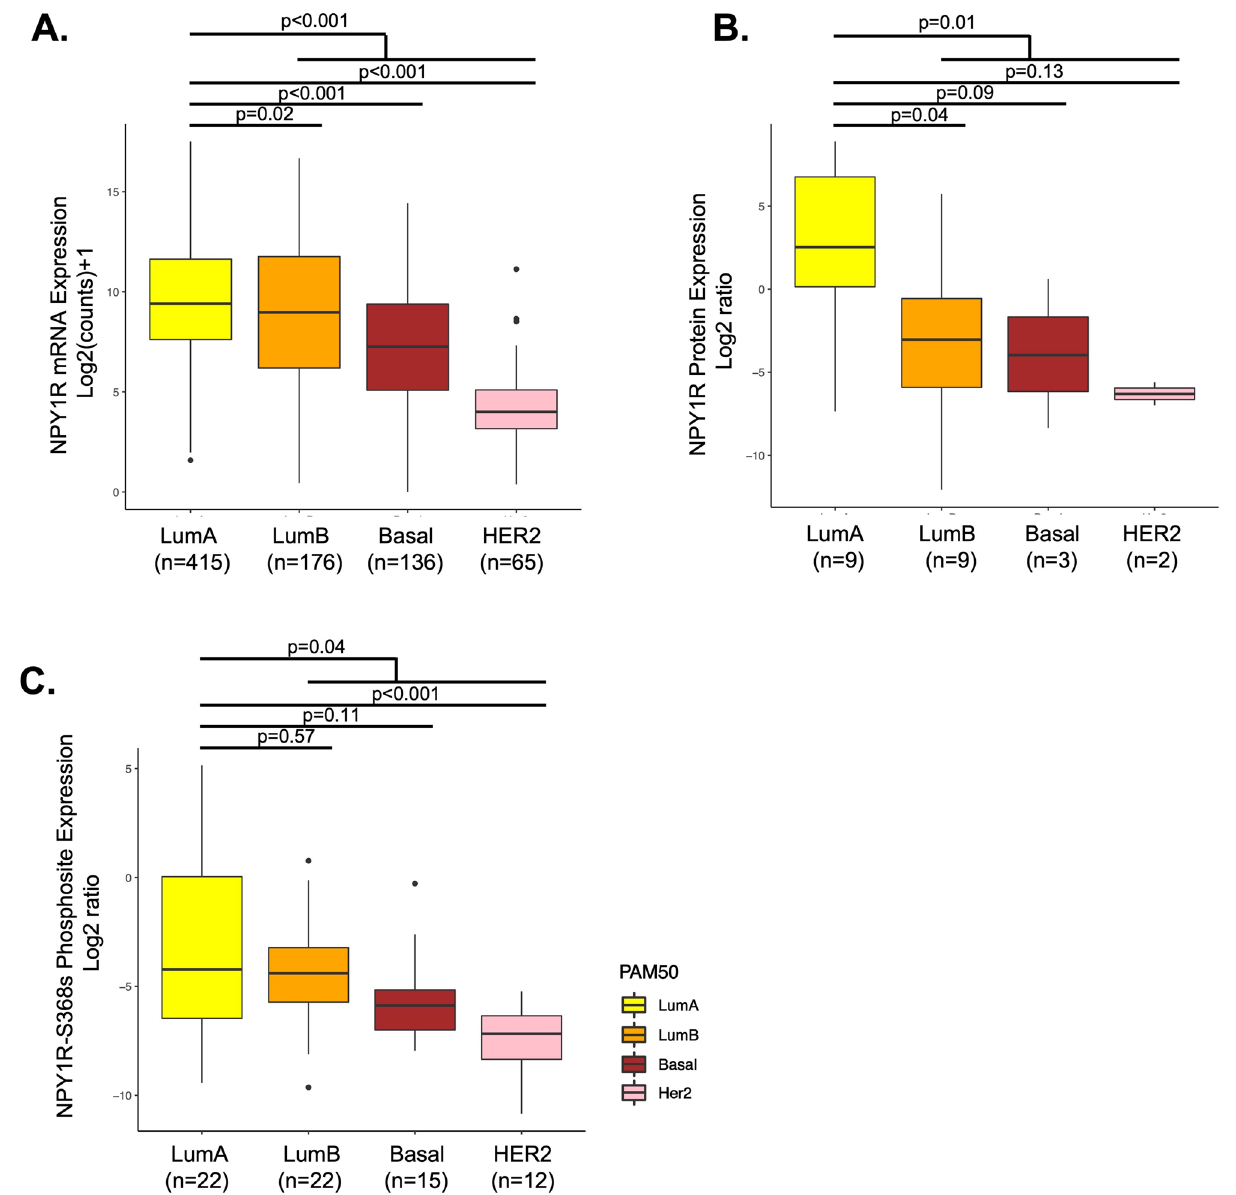
Figure 2. NPY1R expression at mRNA, protein and phosphosite level across BC subtype. ( A ) NPY1R RNA expression in TCGA breast cohort (n = 792), ( B ) protein expression in NCI-CPTAC samples (n = 23), and ( C ) NPY1R-S368s phosphosite expression in corresponding NCI-CPTAC dataset (n = 71). PAM50 subtypes were shown as LumA (yellow), LumB (orange), HER2 (pink) and Basal (brown). Statistical analyses were performed using one-way ANOVA with post-hoc Tukey Test. *indicates p <